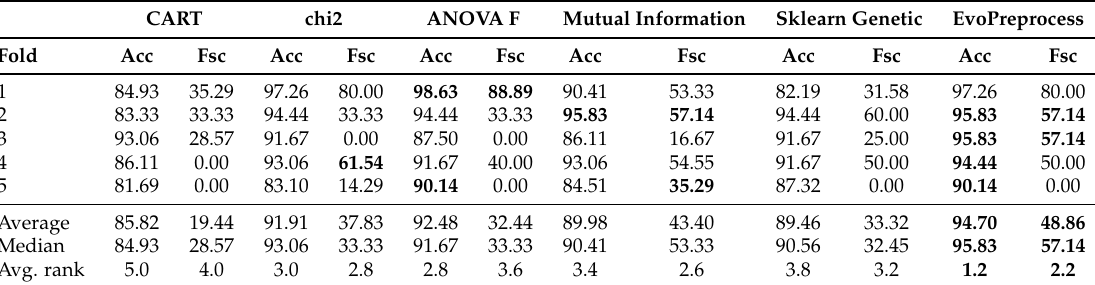
Table 2. Accuracy and F-score results of feature selection. The best values are bolded. CART chi2 ANOVA F Mutual Information Sklearn Genetic EvoPreprocess